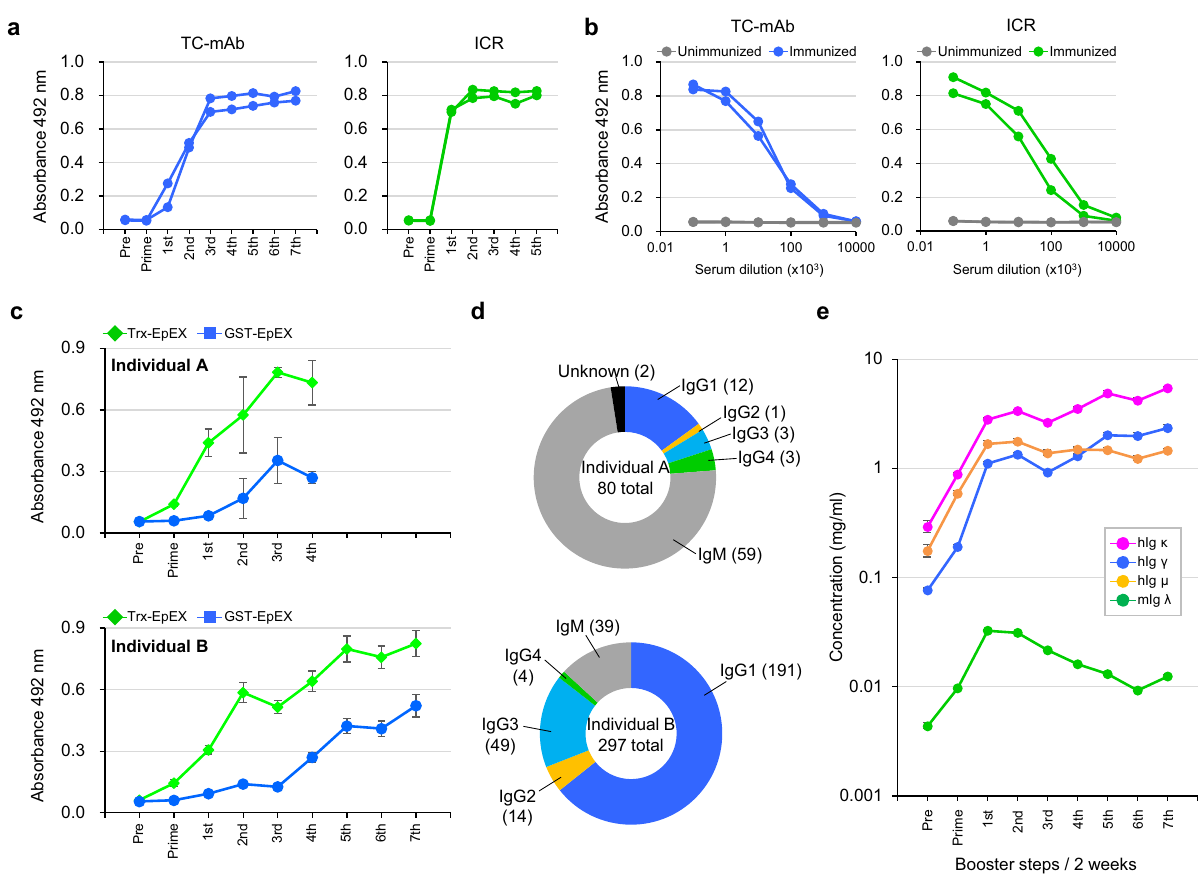
Fig. 6 Immune response and production of monoclonal antibodies in TC-mAb mice. a OVA-speci fi c Ab titre. The titres of Abs against OVA were measured by ELISA using a species-matched secondary Ab. An anti-human IgG-Fc HRP conjugate was used for TC-mAb mice, and an anti-mouse IgG-Fc HRP conjugate was used for ICR. b Comparison of the anti-sera titres. The anti-sera samples were collected from TC-mAb mice after the seventh booster, and from ICR mice after the fourth booster. Samples were serially diluted by 1/10 from 10 2 to 10 7 and used to determine the OVA-speci fi c titre by ELISA. c The antigen-speci fi c titre in TC-mAb mice. Individual A (upper graph) was immunized with Trx-EpEX with the prime and four booster administrations. Individual B (lower graph) was immunized with the prime and seven booster administrations. The titres were analysed using the fusion proteins, Trx-EpEX (green) and GST-EpEX (blue). The Trx-EpEX titre indicated induction of antigen-speci fi c Abs, but that of GST-EpEX indicated administration of EpEX- speci fi c Abs. Each anti-sera was diluted at 8000-fold. Data are presented as means. Error bars indicate the standard deviation of triplicate measurements. d Determination of human Ig-classes. The mouse individual and the total number of class-determined clones are indicated in the centre of the circle. e The serum concentration of different classes of Ab. hIg μ (orange), hIg γ (blue), hIg κ (pink) and mIg λ (green) in the Trx-EpEX immunized TC-mAb mice are represented. Error bars indicate the standard deviation of triplicate